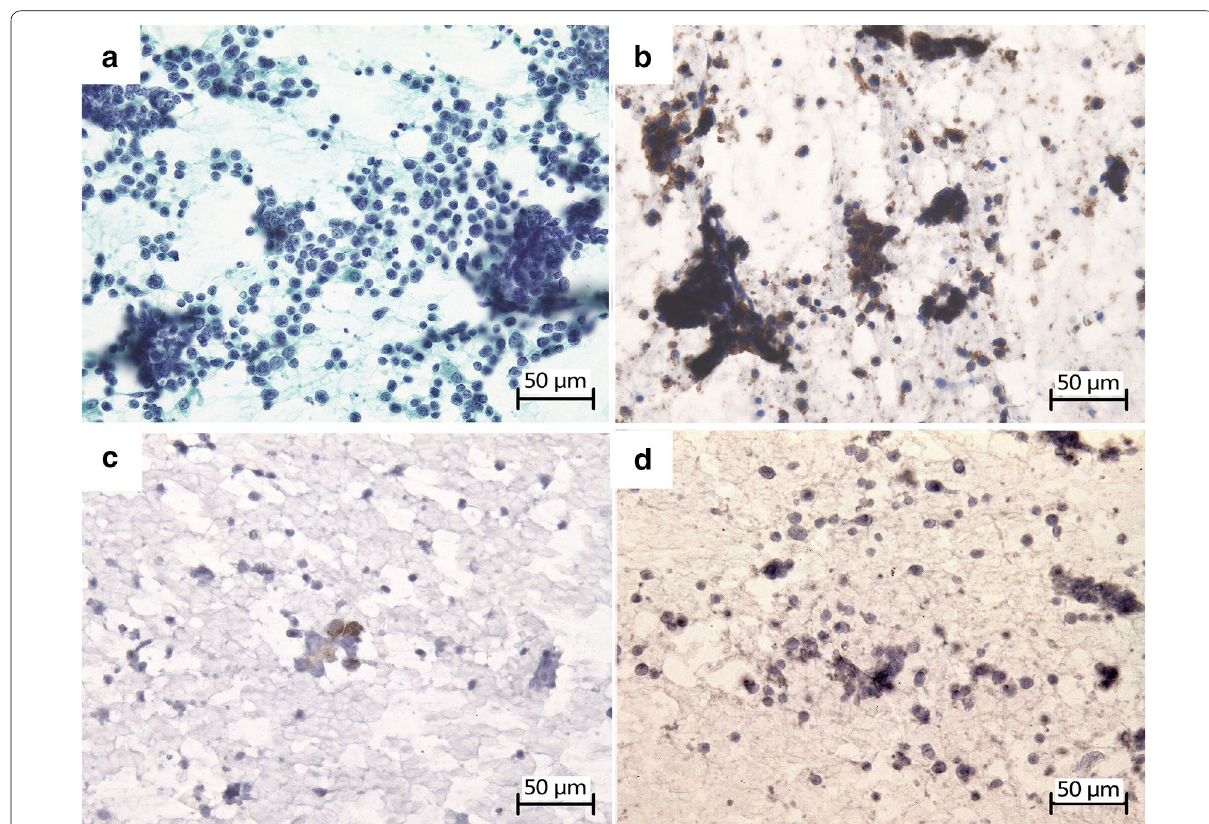
Fig. 4 Cytological findings in the SCLC patient with LEMS at the age of 85 years. Specimens were obtained by cervical lymph node needle aspira- tion biopsy on March 3, 2015. Paraffin-embedded sections were stained with antibody using the polymer method and signal was developed with DAB. Sections were counterstained with hematoxylin. Positive staining for markers in cytoplasm and on cell membrane was indicated in brown . a Cytological examination revealed small cell carcinoma. b CD56 was diffusely and strongly positive on cell membrane. c Chromogranin A was focally and moderately expressed in cytoplasm. d Synaptophysin was not expressed in